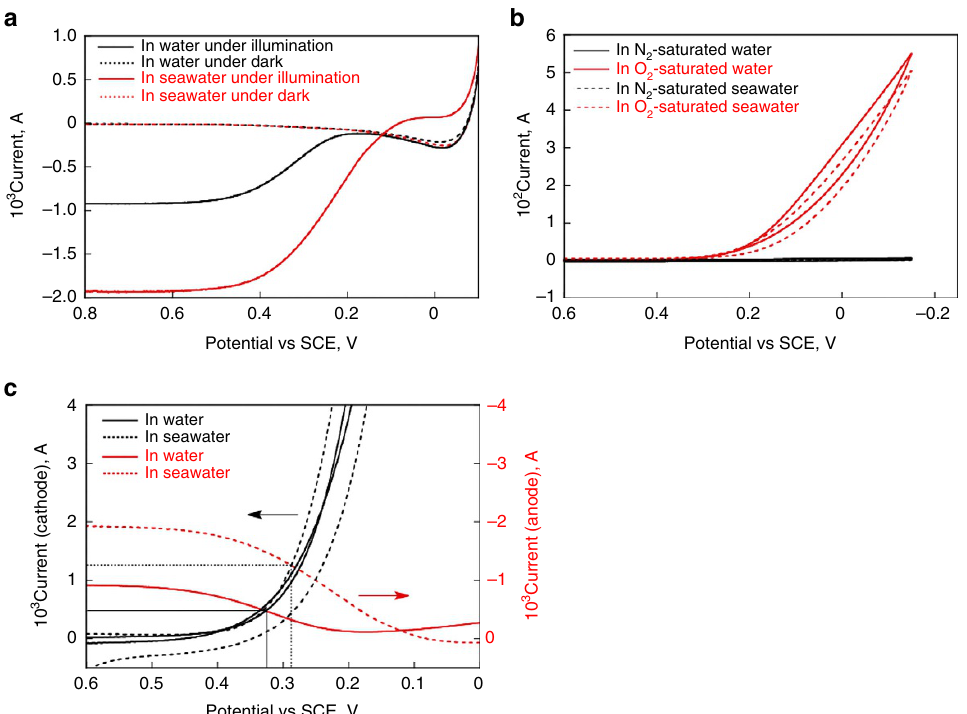
Figure 3 | Photoelectrochemical performance of m-WO 3 /FTO and electrochemical performance of Co II (Ch)/CP. ( a ) I – V curves of m-WO 3 /FTO photoanode in pH 1.3 water (black solid) and in pH 1.3 seawater (red solid) under simulated 1 sun (AM 1.5G) illumination. I – V curves under dark are shown as dashed lines with the same colour definition. Sweep rate: 10mVs (cid:2) 1 . ( b ) Cyclic voltammograms of Co II (Ch)/CP in a N 2 -saturated pH 1.3 water (black solid) and an O 2 -saturated pH 1.3 water (red solid). The dashed lines show the cyclic voltammograms of Co II (Ch)/CP recorded in pH 1.3 seawater. Sweep rate: 20mVs (cid:2) 1 . ( c ) Cyclic voltammograms of Co II (Ch)/CP in O 2 -saturated pH 1.3 solutions (black) and I – V curves of m-WO 3 /FTO photoanode in pH 1.3 solutions (red) under simulated 1 sun (AM 1.5G) illumination.